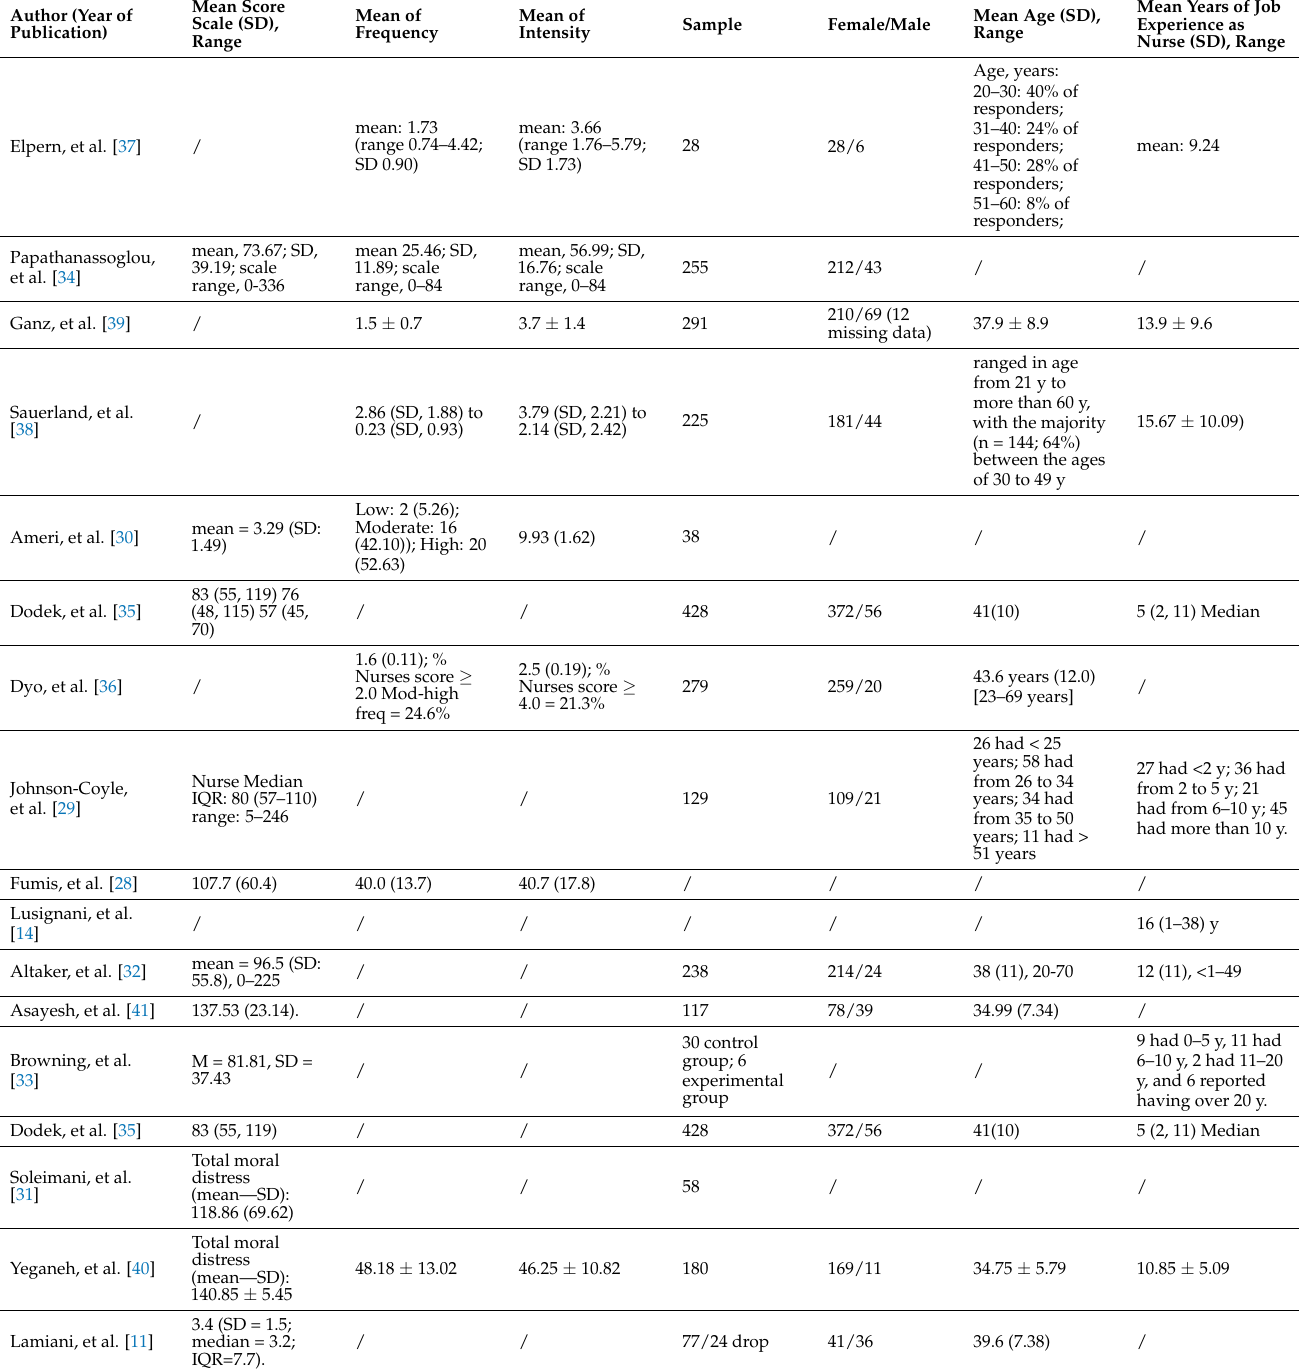
Table 3. Moral distress scores and sample